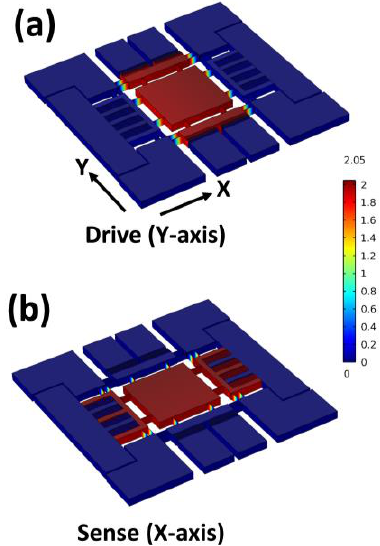
Figure 3. Graphical result of the numerical simulation for the displacement due to the applied force on the ( a ) Y (drive) and ( b ) X (sense)-axes.